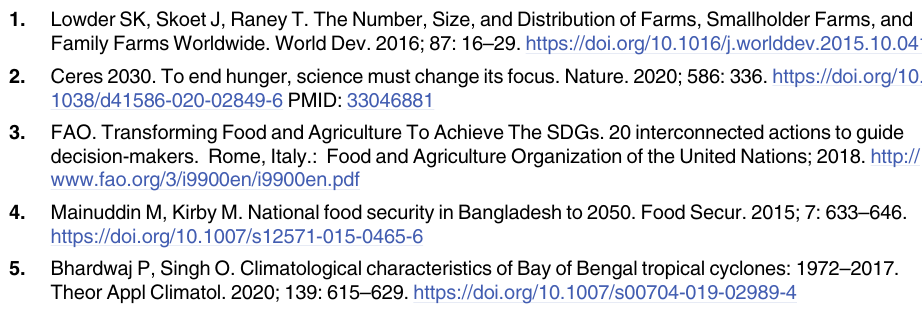
B = Per capita income per day = 1 to 1.99 dollar, C = Per capita income per day = 0.5 to 0.99 dollar, and D = Per capita income per day < 0.5 dollar. (PDF) S1 Fig. Biplots of factors derived from all independent variables. (TIF) S2 Fig. Changes in crop productivity, household annual crop production, and the contri- bution of different cultivated crops to household annual crop production (% of rice equiv- alent yield) within polder and outside polder areas over time. (TIF) S3 Fig. The deficit of crop income to fulfill household food expenses. (1 USD = 69.65 BDT). (TIF) S4 Fig. The importance of the latent factors on households’ annual rice equivalent crop production (t household -1 year -1 ) and rice equivalent crop productivity (t ha -1 ).